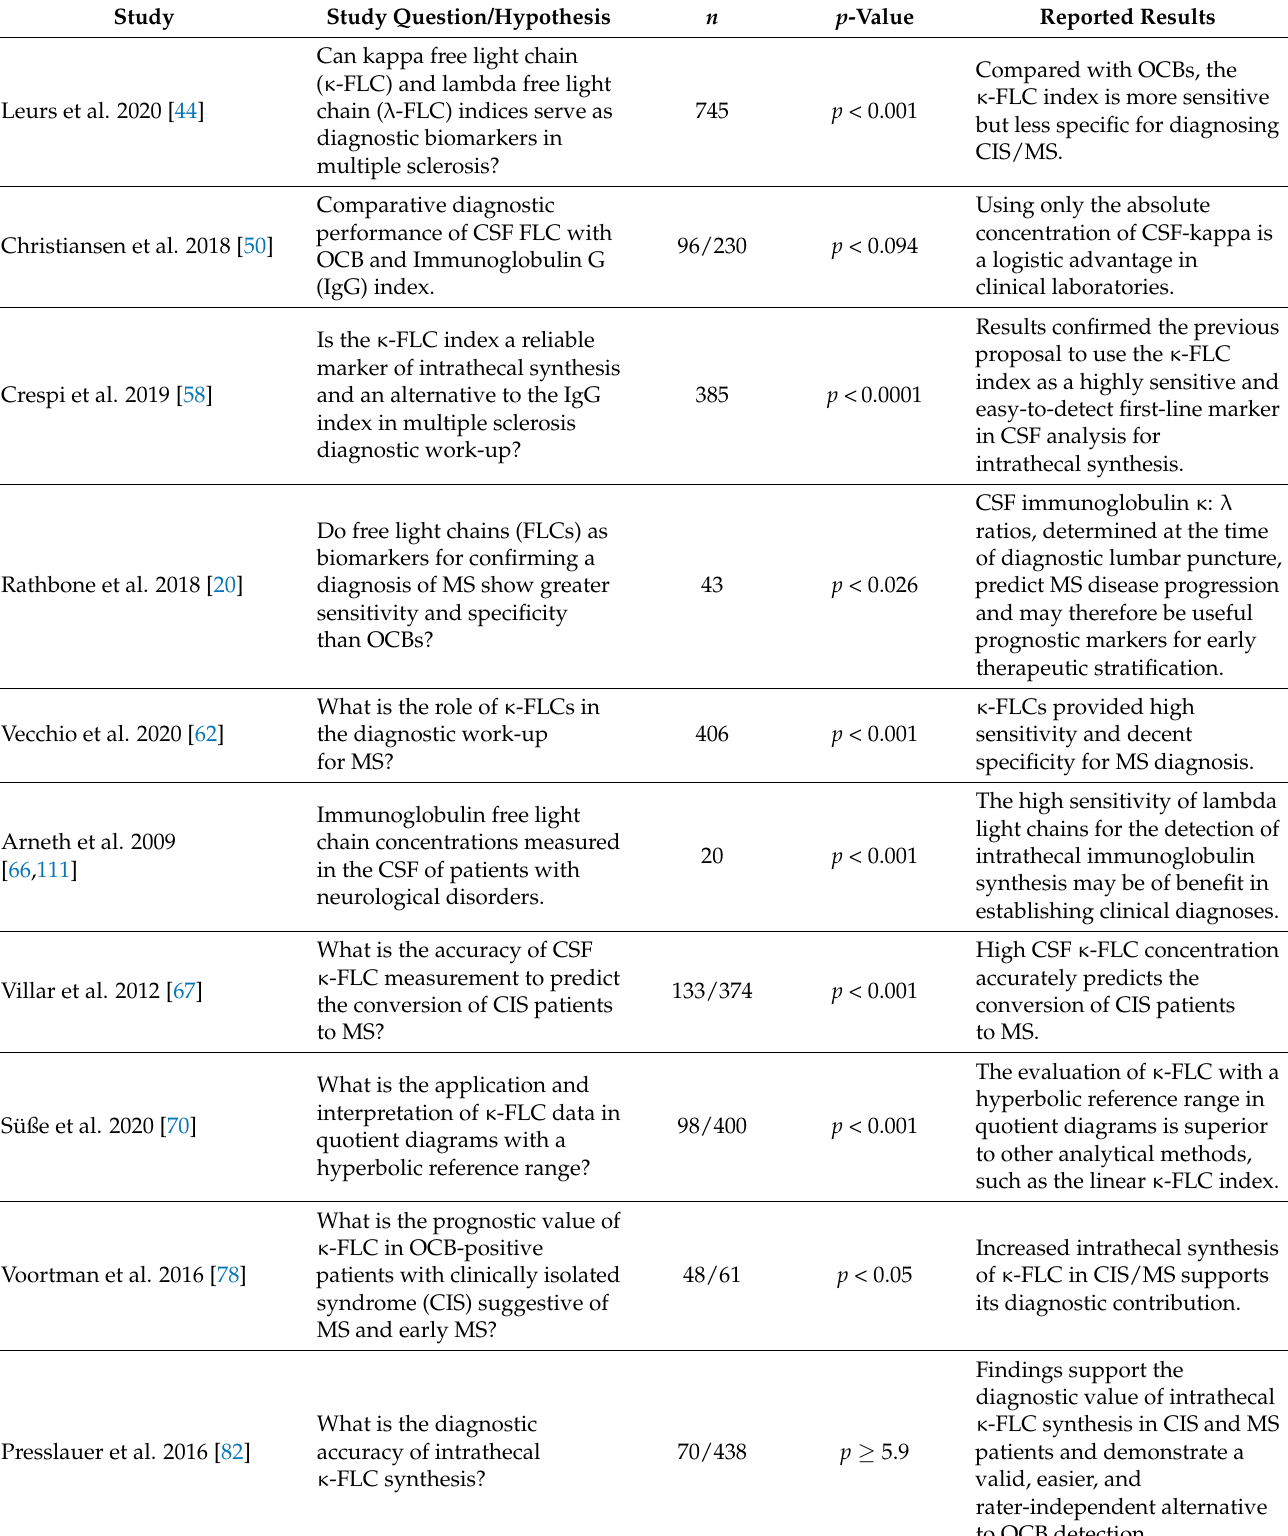
Table 3. A summary of the most important studies on the role of free light chains in MS